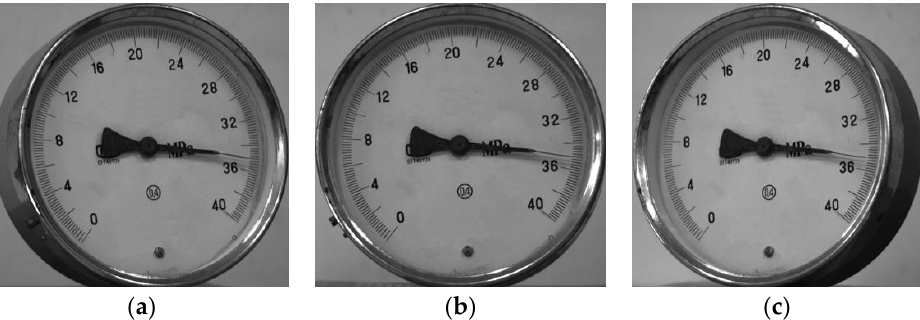
Figure A9. The meter image taken by camera from three angles when the reading of the pointer meter Figure A9. the meter image taken by camera from three angles when the reading of the pointer Figure A9. the meter image taken by camera from three angles when the reading of the pointer Figure A9. the meter image taken by camera from three angles when the reading of the pointer Figure A9. the meter image taken by camera from three angles when the reading of the pointer is 35.1; ( a ) the camera at position 1; ( b ) the camera at position 2; ( c ) the camera at position meter is 35.1; ( a ) the camera at position 1; ( b ) the camera at position 2; ( c ) the camera at position 3. meter is 35.1; ( a ) the camera at position 1; ( b ) the camera at position 2; ( c ) the camera at position 3. meter is 35.1; ( a ) the camera at position 1; ( b ) the camera at position 2; ( c ) the camera at position 3. meter is 35.1; ( a ) the camera at position 1; ( b ) the camera at position 2; ( c ) the camera at position 3.